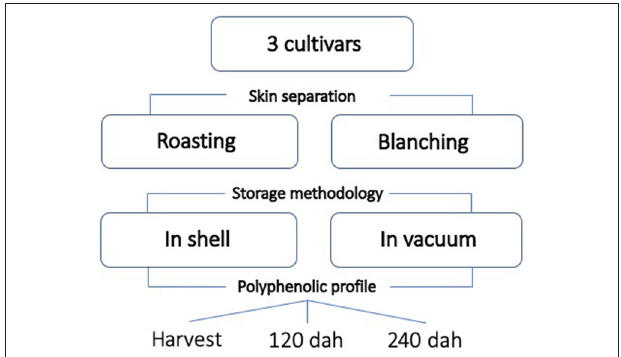
FIGURE 1 | Experimental framework reporting all the treatments and the variables applied (dah: days after harvest). Ten plants were selected within the plot for each cultivar; at harvest, the in-shell yield per tree was weighed and, after sun drying, the shelling rate and the fraction attributable to the skin were measured.